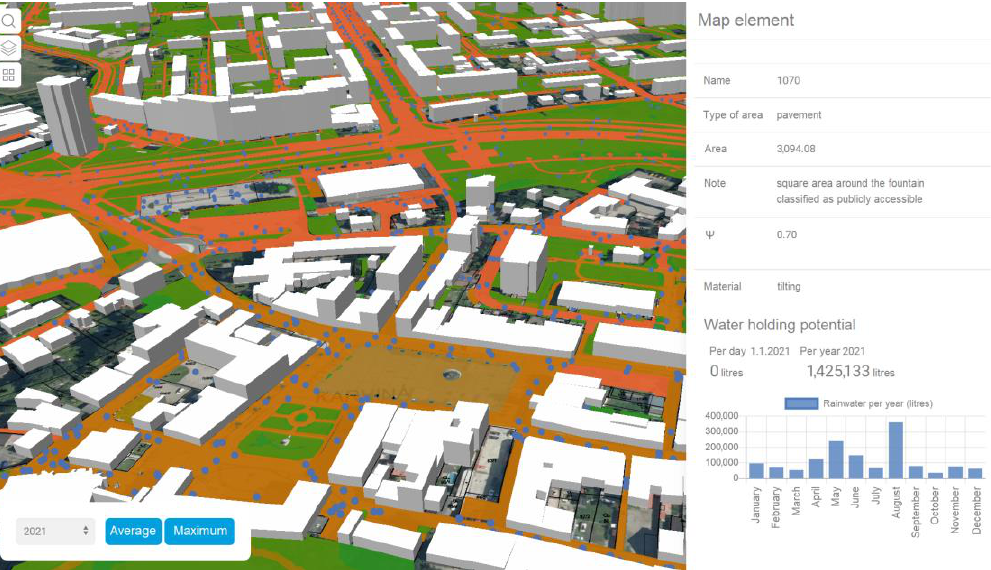
Figure 4. Demonstration of the database and functionalities expanding the map data for the use of R-WIM (source: authors). R-WIM (source: